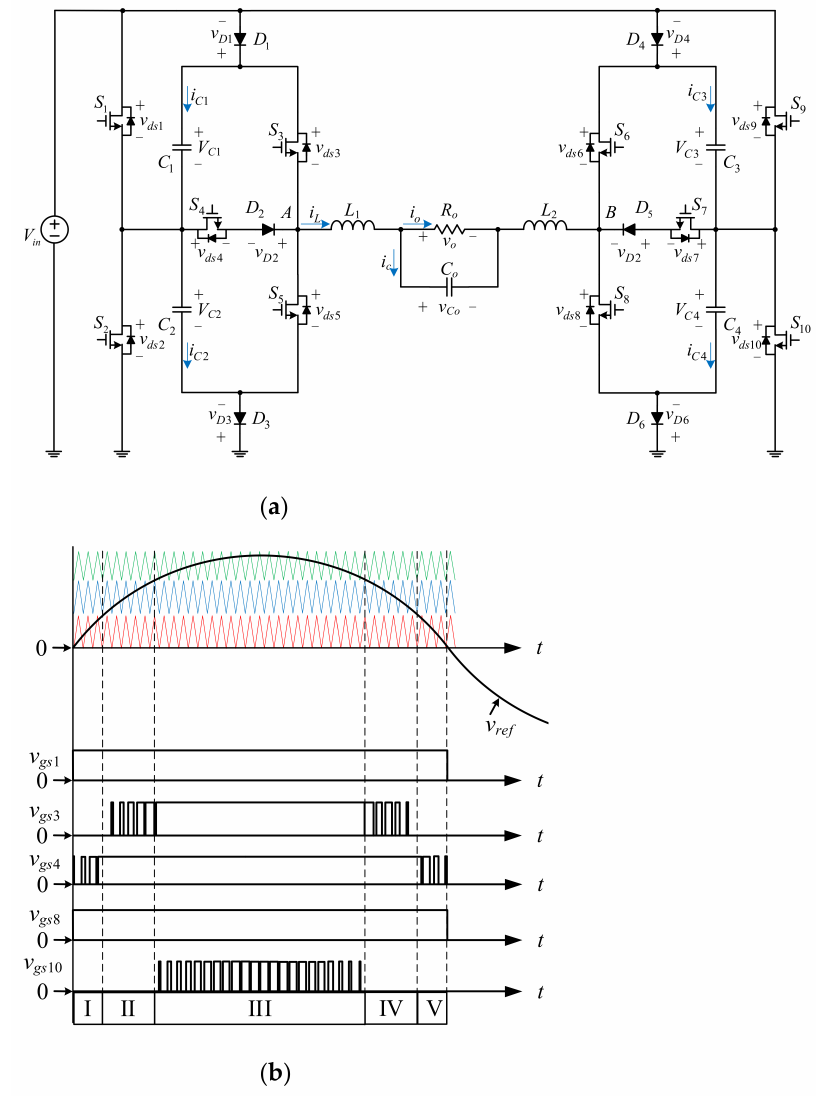
Figure 2. Proposed inverter and PWM control strategy: ( a ) Single-power-source T-type 7-level single-phase DC-AC inverter; ( b ) Gate signals of the